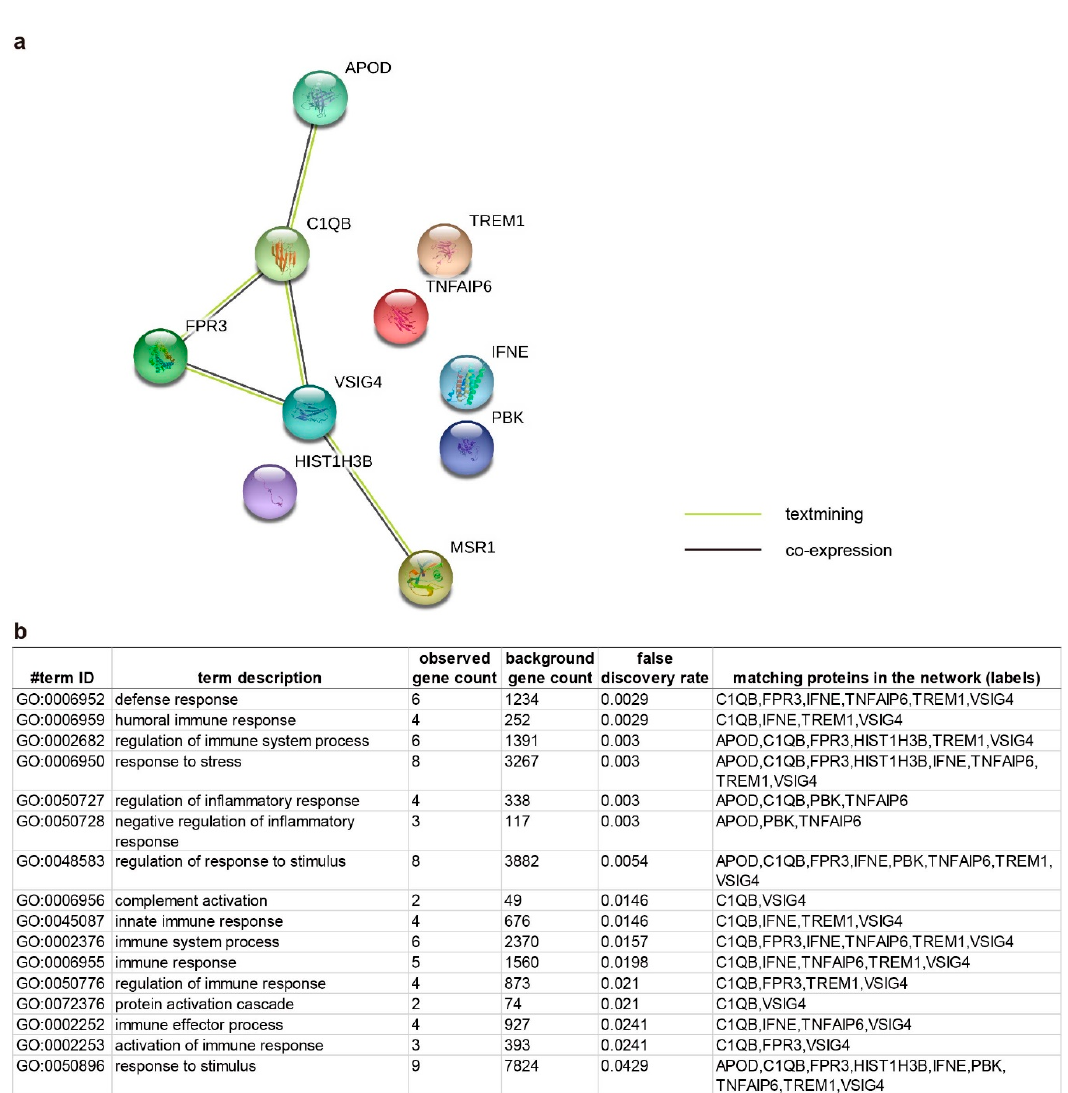
Figure 5. STRING database displayed the protein-protein interaction network among the 10 common differential expressed genes (DEGs) in cartilage and synovium that related to inflammation modulating. ( a ) the diagram generated from the STRING data based to demonstrate the potential interactions. ( b ) The list contains identified pathways with a false discovery rate (FDR) less than 0.05. APOD — Apolipoprotein ; C1QB — complement C1q subcomponent subunit B ; FPR3 — N-formyl peptide receptor 3 ; HIST1H3B — histone cluster 1 H3 family member b ; IFNE — Interferon epsilon ; MSR1 — Macrophage scavenger receptor type I and II ; PBK — Lymphokine-activated killer T-cell-originated protein kinase ; TNFAIP6 — Tumor necrosis factor-inducible gene 6 protein ; TREM1 — Triggering receptor expressed on myeloid cell 1 ; VSIG4 — V-set and immunoglobulin domain containing 4